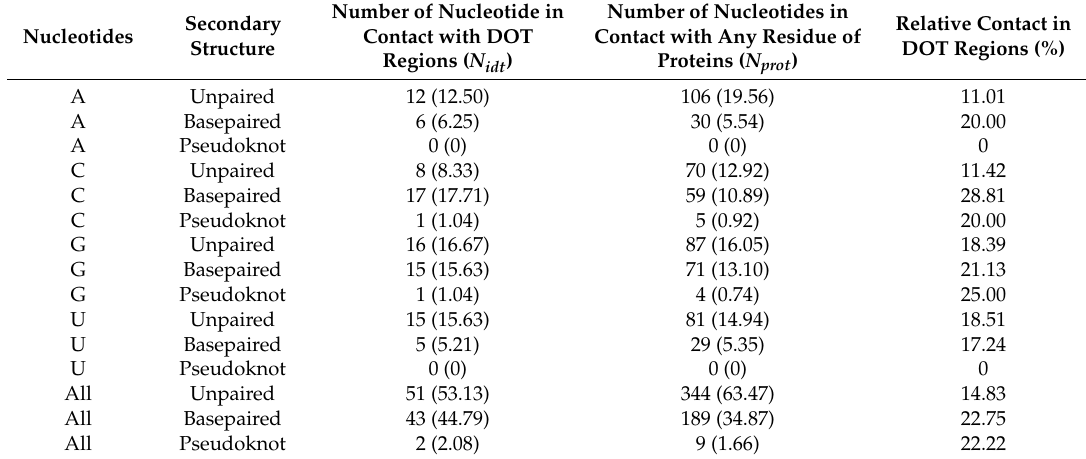
Table 4. Preference of nucleotides in different secondary structures to bind with DOT residues. Secondary Nucleotides